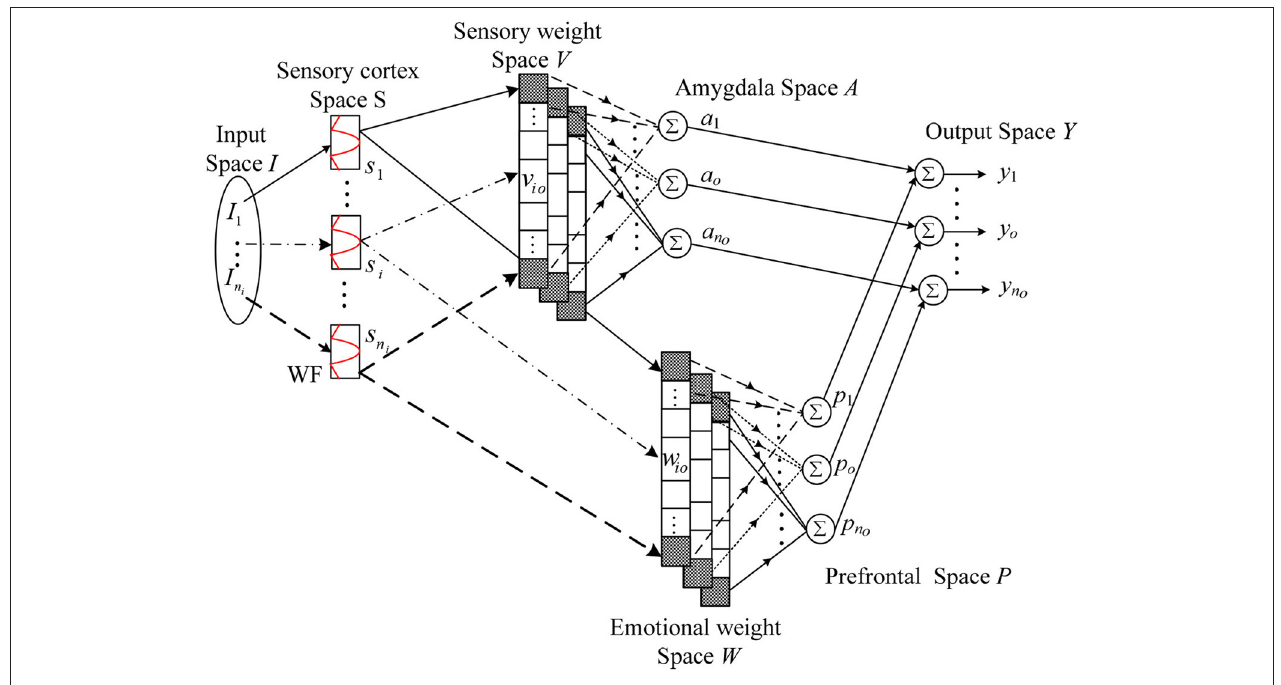
FIGURE 1 | Structure of